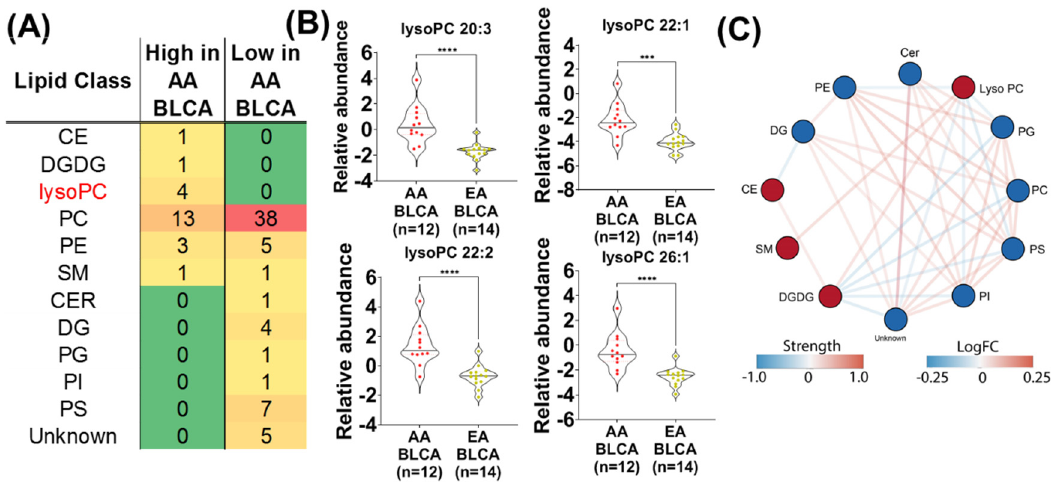
Figure 2. ( A ) Table represents the number of each class of lipids that are high and low in AA BLCA (n = 12) compared to EA BLCA (n = 14). ( B ) Violin plots represent the expression of four lyso PCs (lyso PCs 20:3, lyso PCs 22:1, lyso PCs 22:2, and lyso PCs 26:1) in AA BLCA (n = 12) compared to EA BLCA (n = 14) (data from panel A; same lipids represented in panel B) ( t ‐ test; **** indicating p < 0.0001; *** indicating p < 0.001). ( C ) A correlation network was inferred for differential lipid classes between AA and EA BLCA. Node color represents the significantly altered lipid species highlighting their decreased (blue) or increased (red) expression. Red edge represents positive correlation and blue edge represents negative correlation.